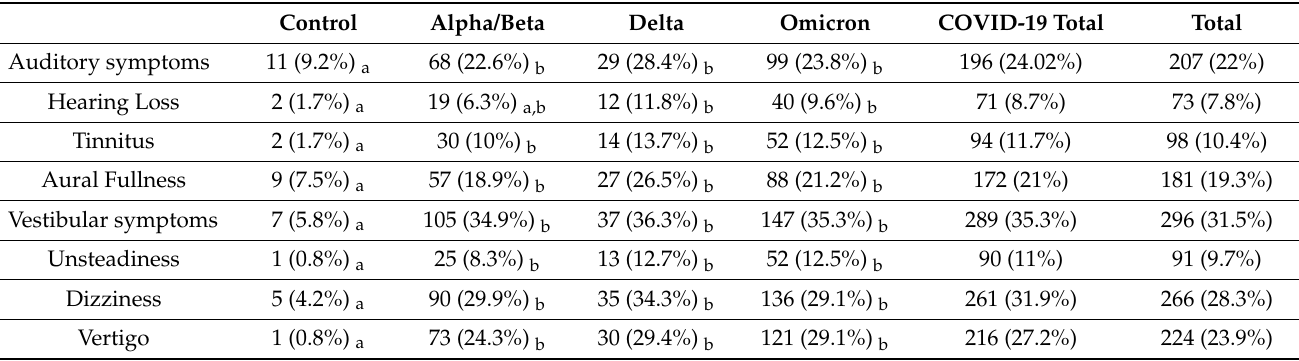
Table 2. Post-hoc analyses with Bonferroni correction for auditory and vestibular symptoms across variants compared to uninfected controls.